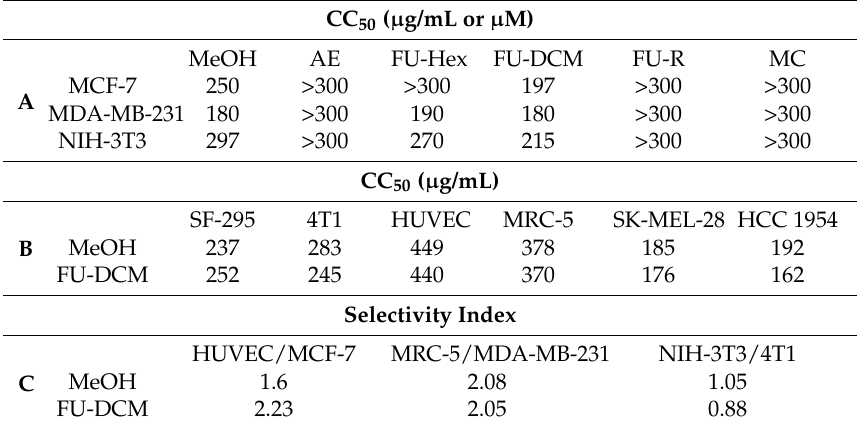
Table 3. CC 50 values of F. umbellata extracts in tumoral and non-tumoral cell lines.